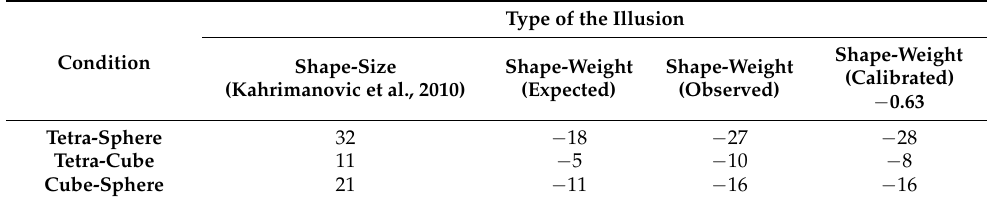
Table 6. Magnitude of the bias between three shapes